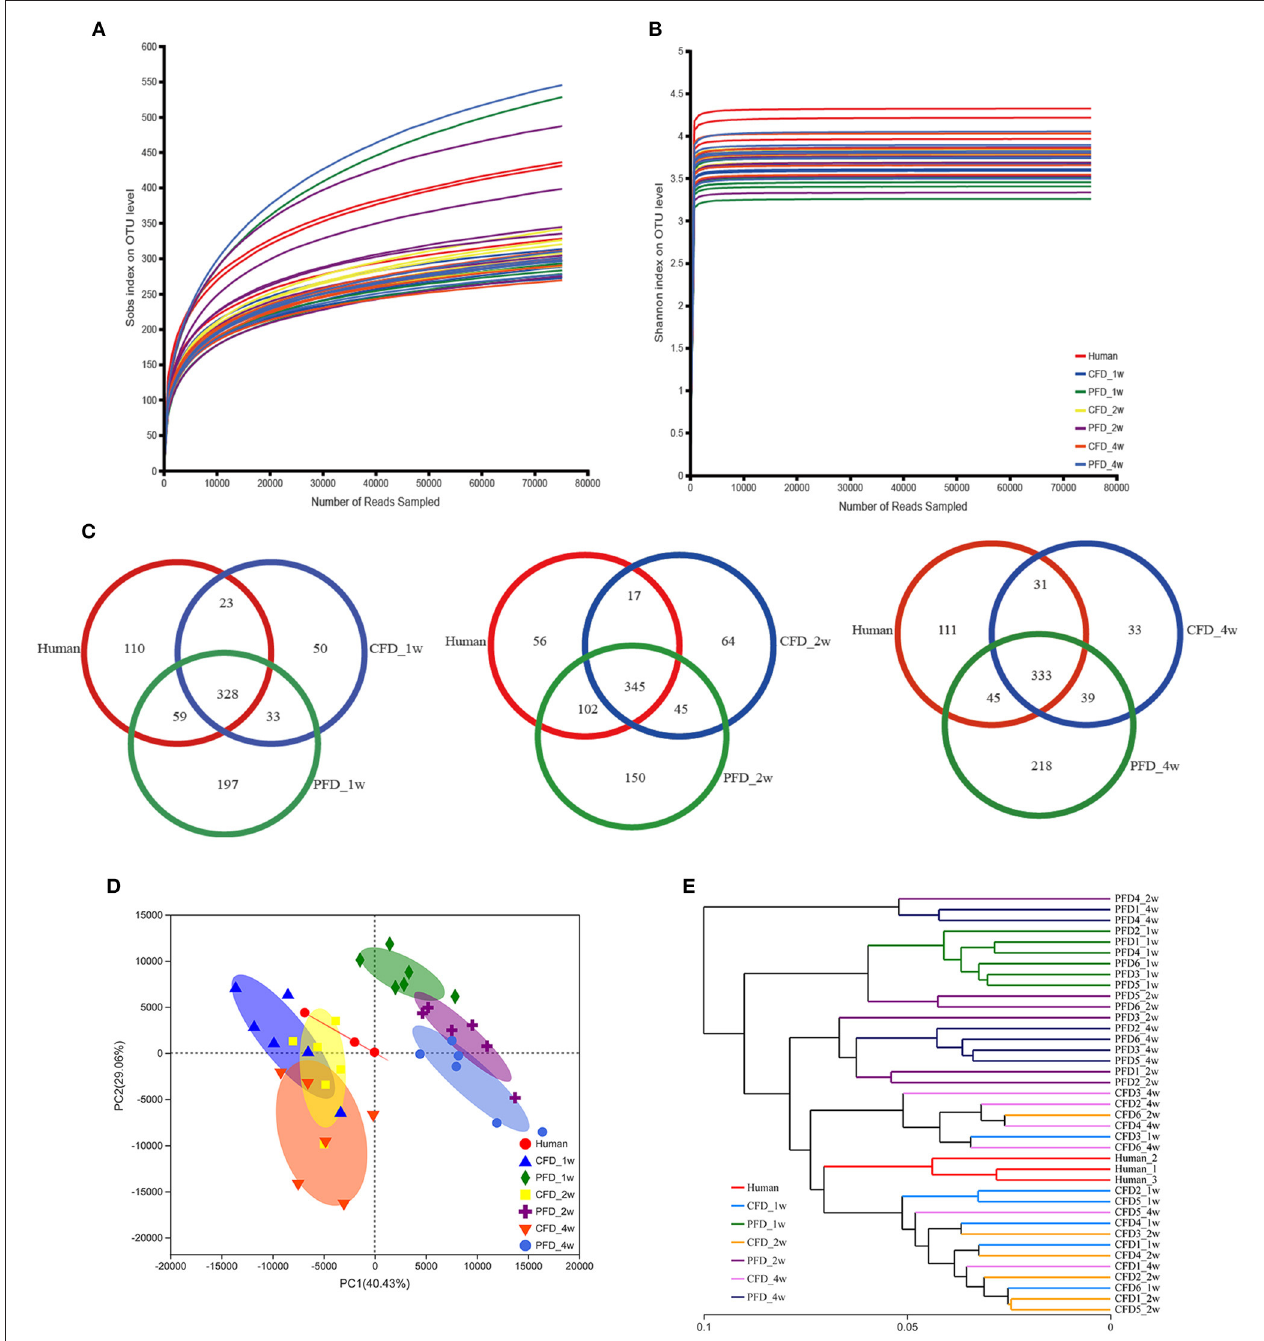
FIGURE 2 | Overall profile of the gut microbiota. (A) Rarefaction curves of OTUs determined at the 97% similarity level. (B) Rarefaction curve according to the Shannon metric for the groups by the Mothur software. (C) Venn diagram of identified OTUs at 1, 2, 4 weeks. Sample sorting analysis. (D) Scatter plot of PCA-score shows the closer of the groups’ points are, the more similar of the species composition in groups. Principal components (PCs) 1 and 2 explained 40.43 and 29.06%, respectively. (E) Based on the Weighted UniFrac distance, hierarchical clustering tree on the OTU level analysis is executed of all samples.